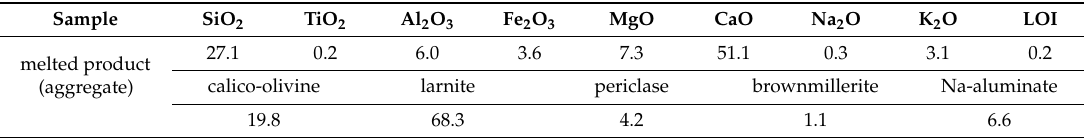
Table 2. Results of the chemical analysis and quantitative X-ray phase analyses of the obtained aggregate (values in